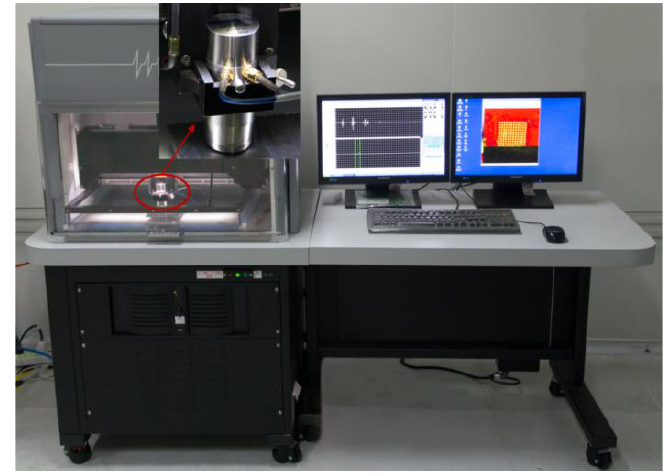
Figure 4. The Scanning Acoustic Microscopy equipment (Sonoscan D9500).